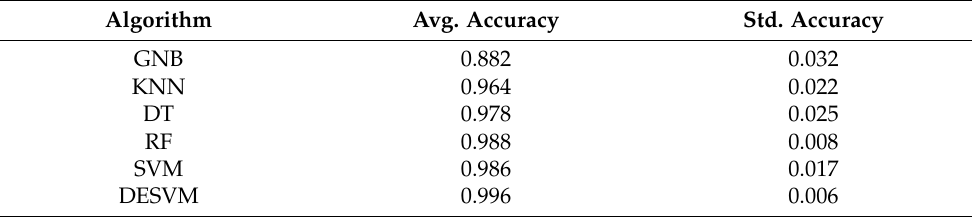
Table 3. The average (Avg) and standard deviation (Std) of the accuracy for ten-fold cross-validation.